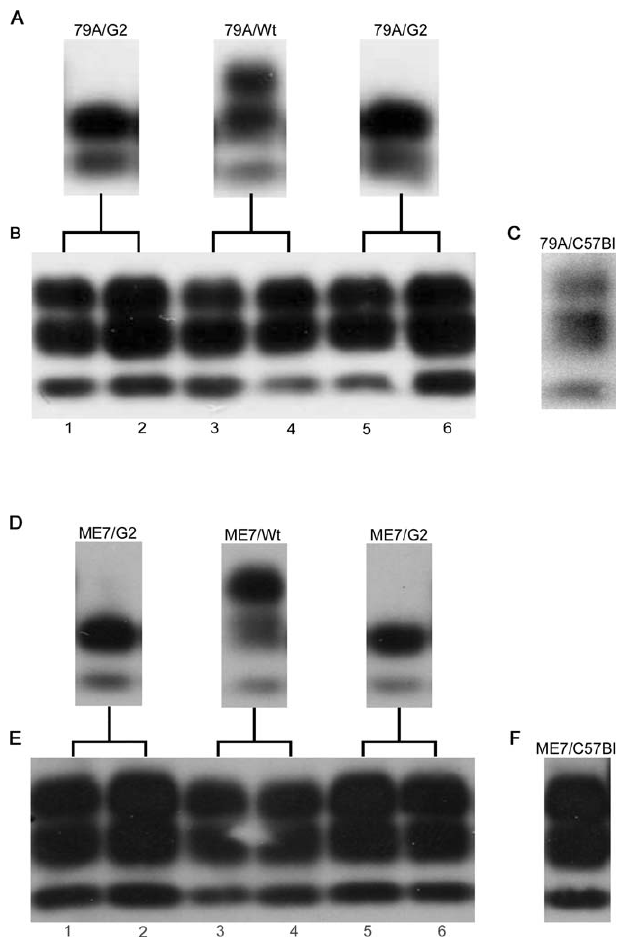
Figure 5. Western Blot Analysis of Brains from Second Passage of 79A- Infected G2 and Wild-Type Mice Brain homogenates from (A) clinically and pathologically positive 79A inoculated G2 or wild-type, 129/Ola (Wt), mice were used to i.c. inoculate 129/Ola mice. (B) The 79A inoculated G2 mouse brains lacked diglycosylated PrP Sc , but all 129/Ola mice inoculated with 79A/G2 or 79A/Wt brain material had di-, mono-, and unglycosylated PrP Sc . (C) Brain of a C57Bl mouse infected with 79A used as comparison for the glycotype. Brain homogenates from (D) clinically and pathologically positive ME7 inoculated-G2 or wild-type, 129/Ola (Wt), mice were used to intra- cerebrally inoculate 129/Ola mice. (E) The ME7 inoculated G2 mouse brains lacked diglycosylated PrP Sc but all 129/Ola mice inoculated with ME7/G2 or ME7/Wt brain material had di-, mono-, and unglycosylated PrP Sc . (F) Brain of a C57Bl mouse infected with ME7 used as comparison for the glycotype. Lanes 1–6: TSE-inoculated 129/Ola mouse brain. All samples were PK